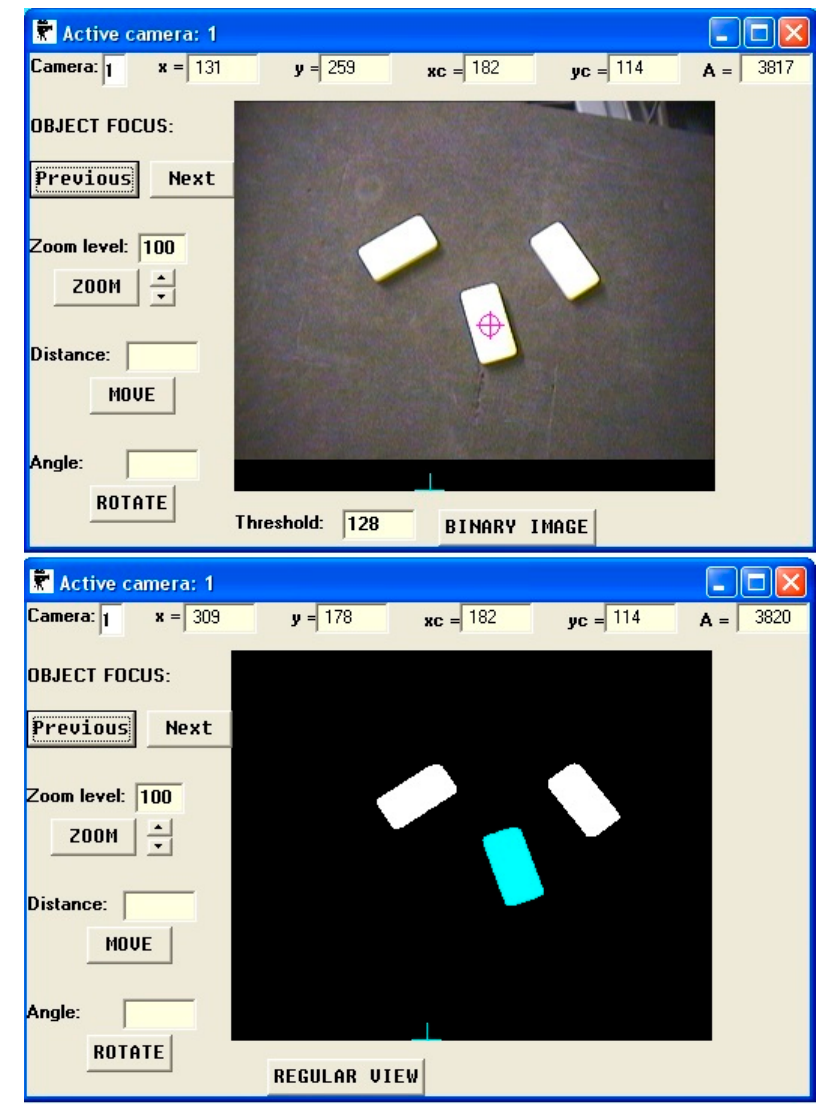
Figure 1. Graphical User Interface of image recognition system used in experiments.